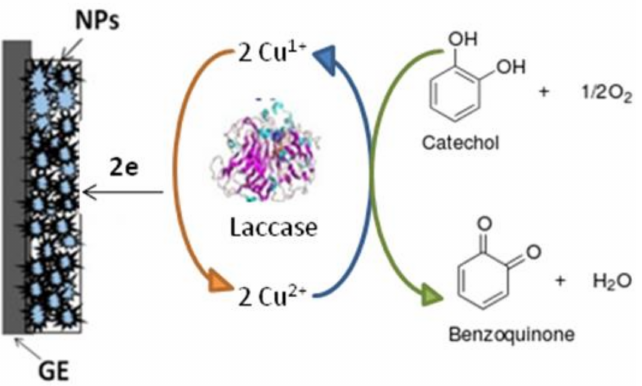
Figure 2. The principal scheme of catechol determination using a laccase-based